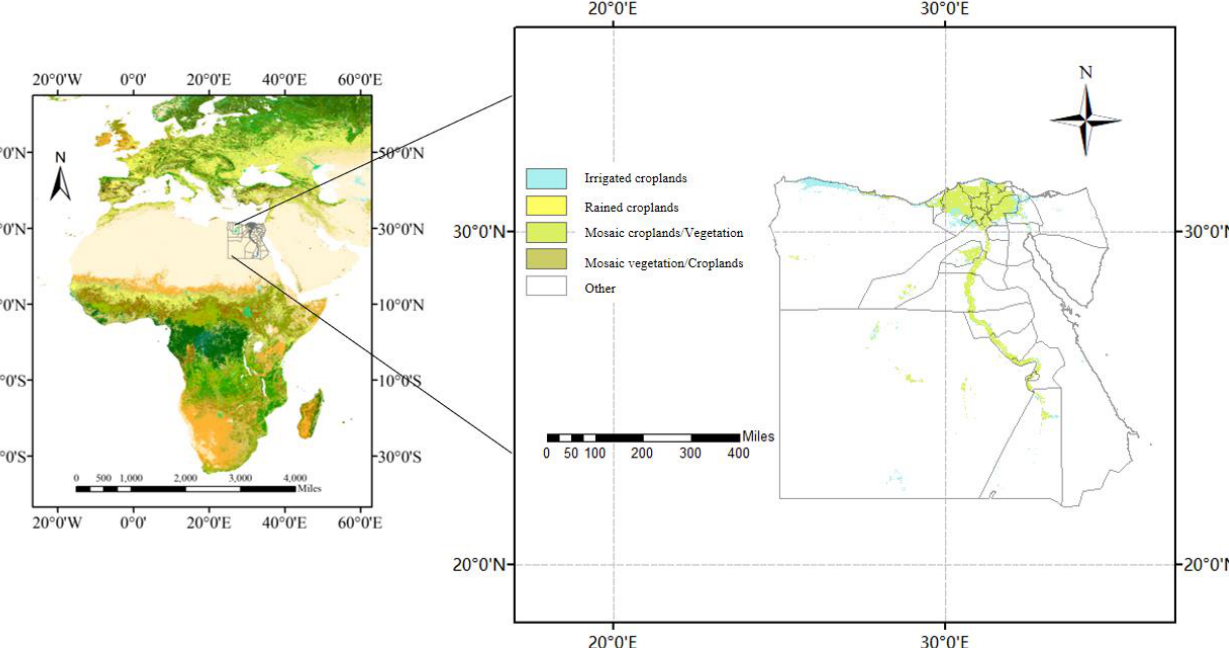
Figure 1. Geographic distribution of cropland in Egypt.